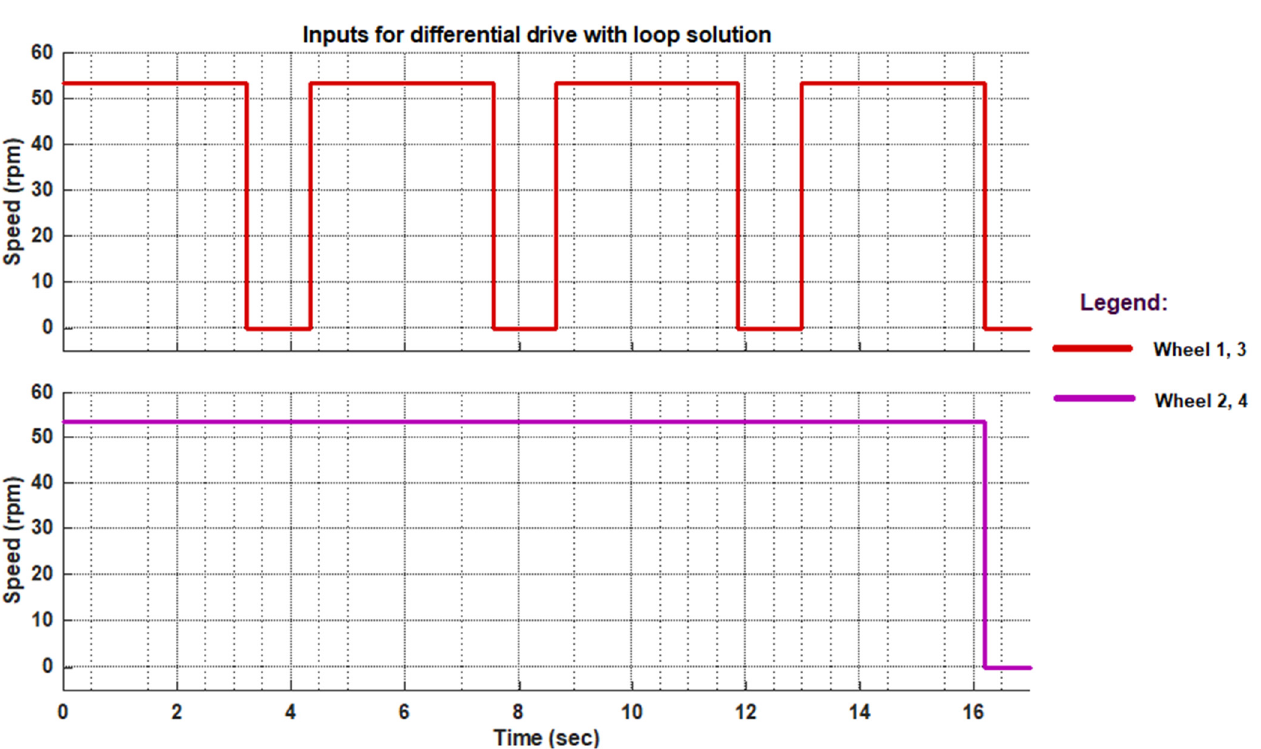
Figure 10. Inputs for the differential drive with loop kinematic solution (speed of the wheels). Table 9. Inputs for the four-wheel Mecanum kinematic solution—values.